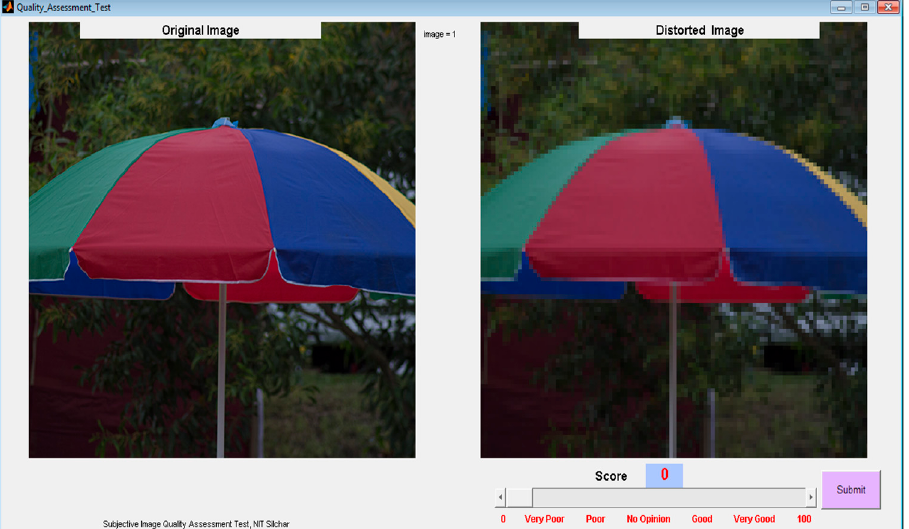
Figure 6. G raphical user interface (GUI)-2.